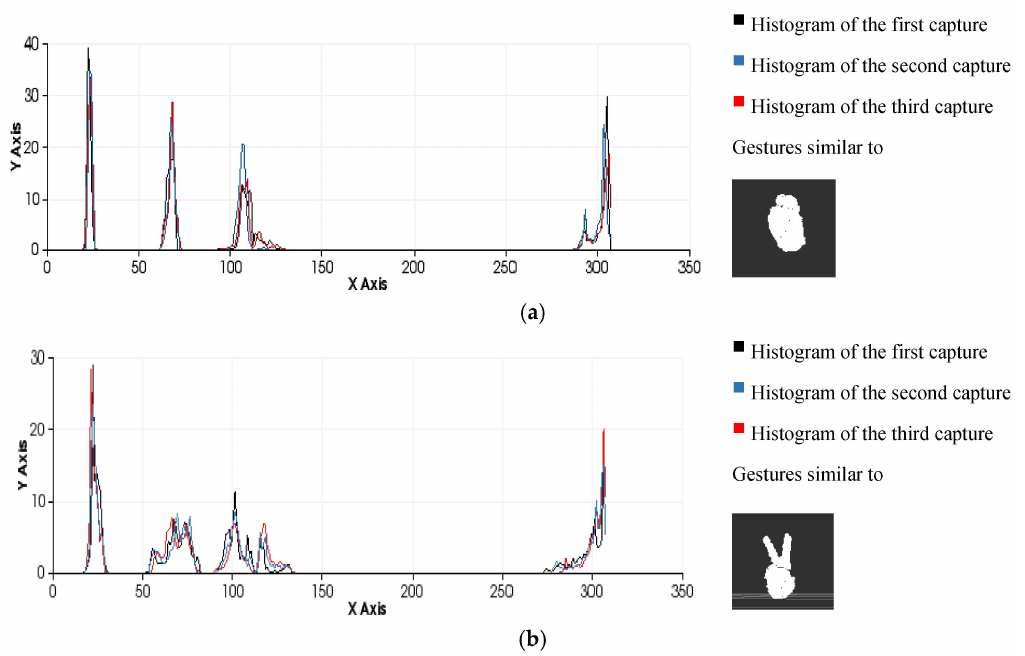
Figure 11. Examples of the gesture classification process performed by comparing histograms using the minimum Euclidean distance as a similarity metric. ( a ) Gesture